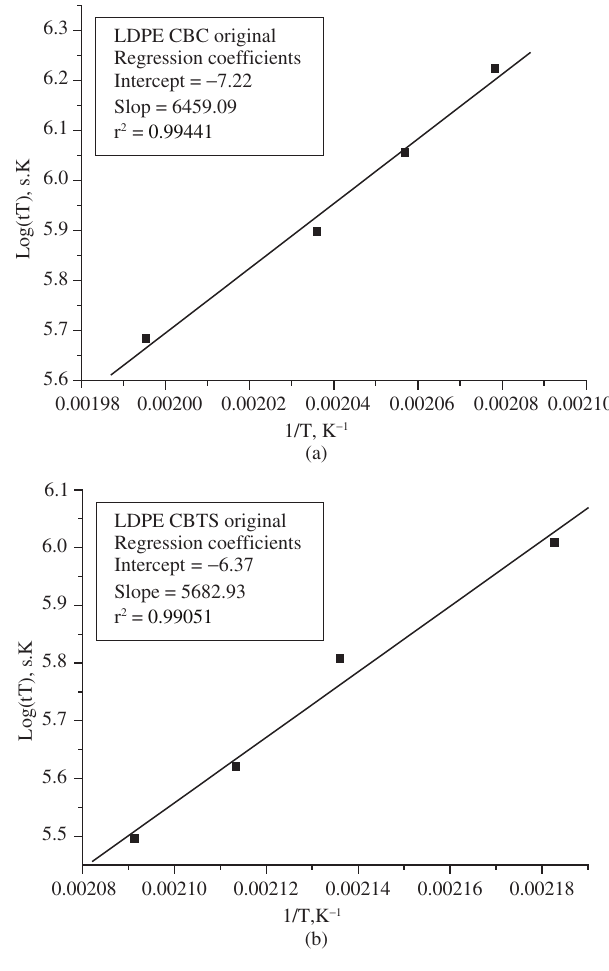
Figure 7. Examples of OIT data plotted in Eiring coordinates: a) original CBC sample and b) original CBTS sample.